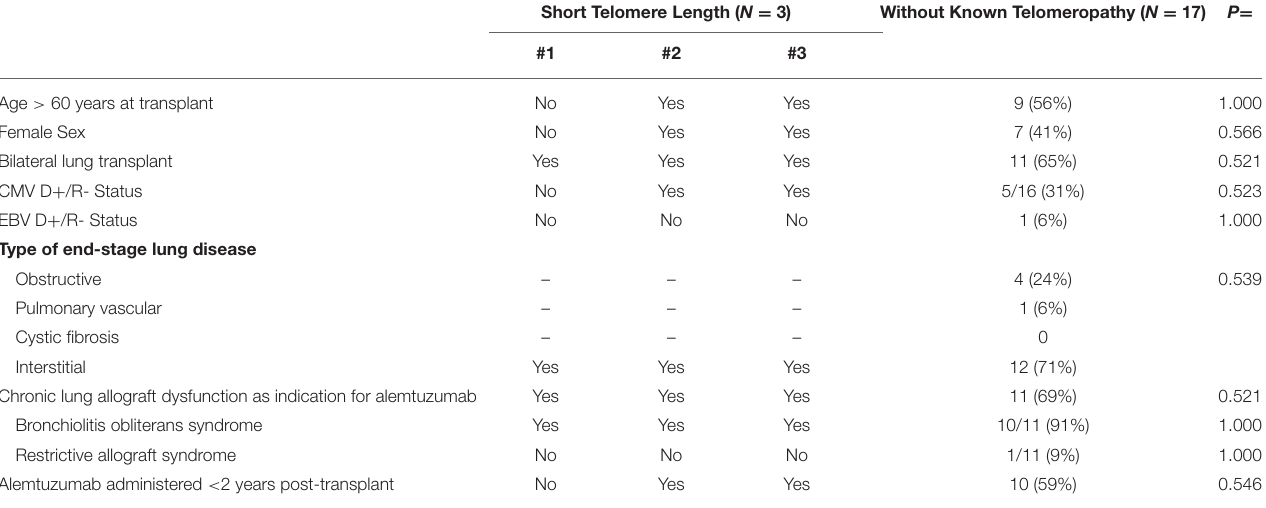
TABLE 2 | Baseline characteristics of patients that received alemtuzumab for ACR or